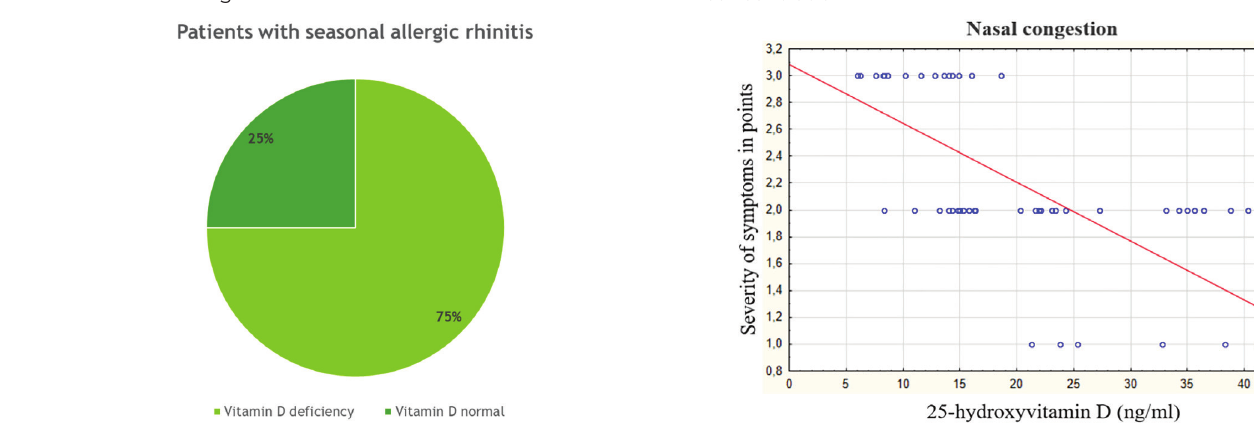
Figure 2 - Prevalence of vitamin D deficiency among patients with seasonal allergic rhinitis